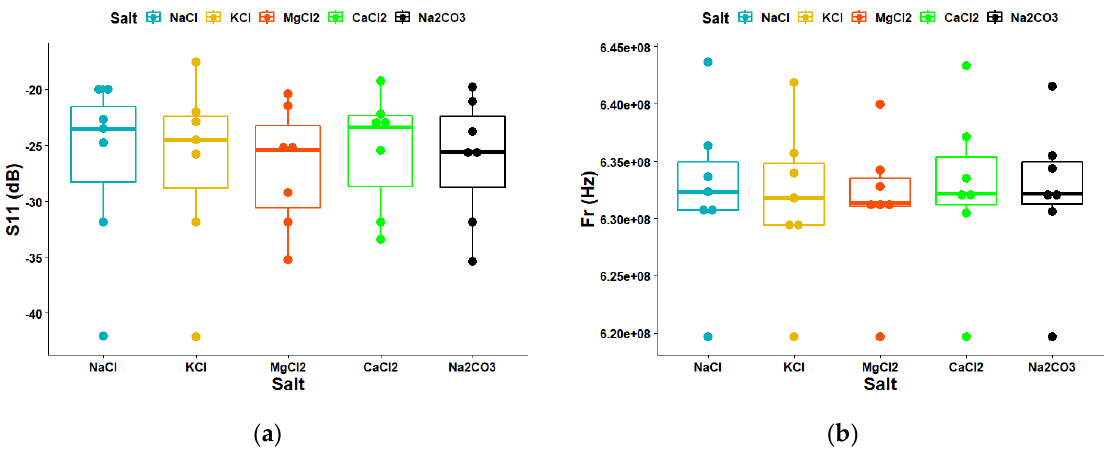
Figure 11. The distribution characteristics of the raw data were compared in each group obtained from the second resonance peak: ( a ) boxplot (S 11 ) and ( b ) boxplot (F r ).